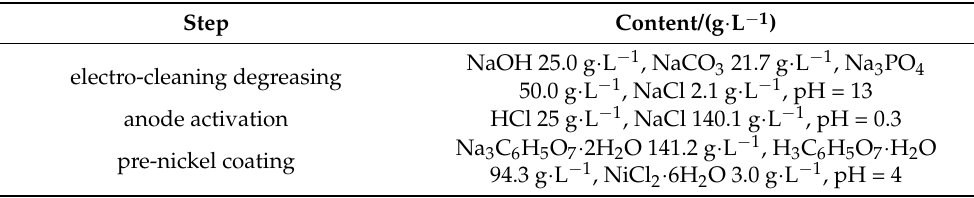
Table 3. Electric oil removal and activation solution